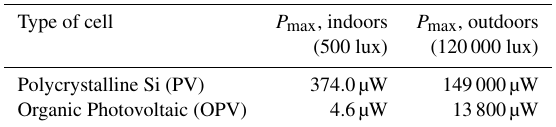
Table 3. Maximum power (µW) harvested by the PV and OPV un- der different illumination